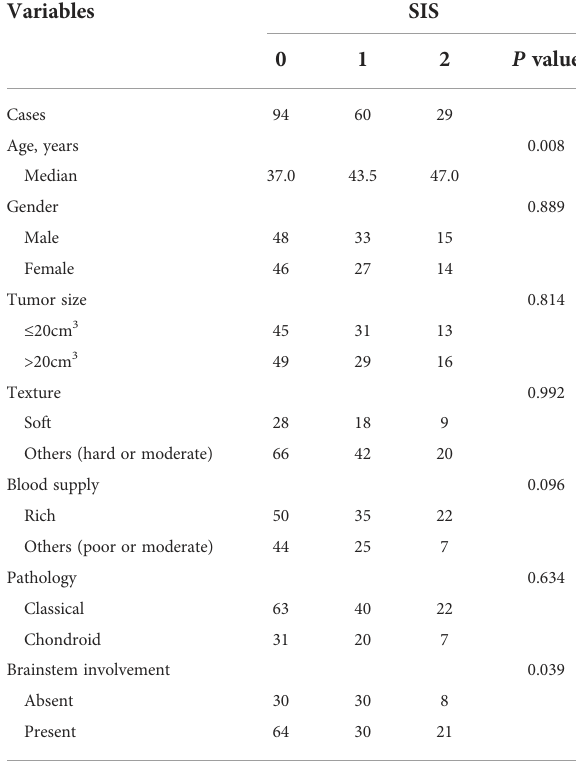
TABLE 1 Association between SIS and clinicopathological features in skull base